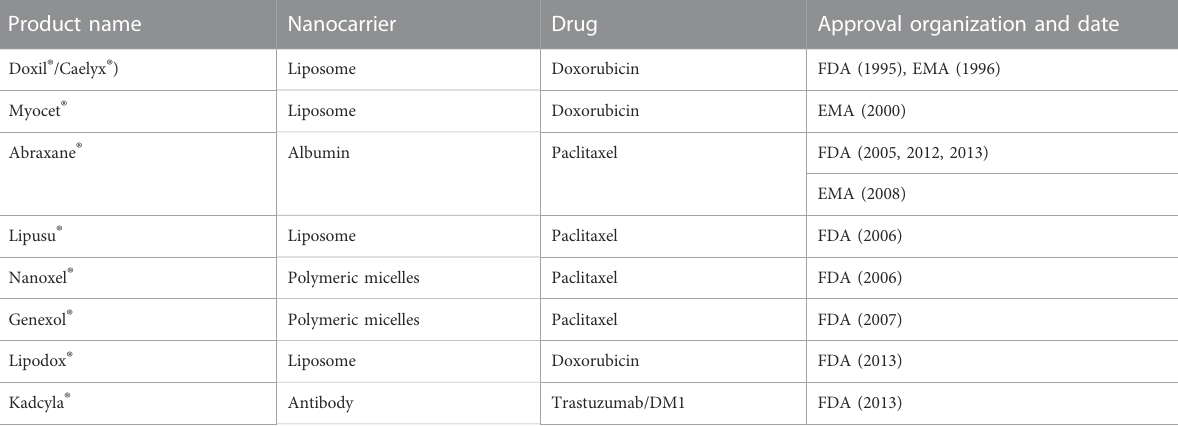
TABLE 1 Approved nanomedicine for the treatment of breast